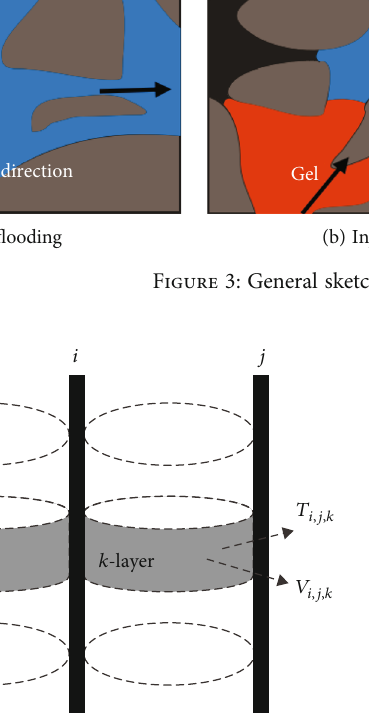
Figure 4: Schematic diagram of connected unit.